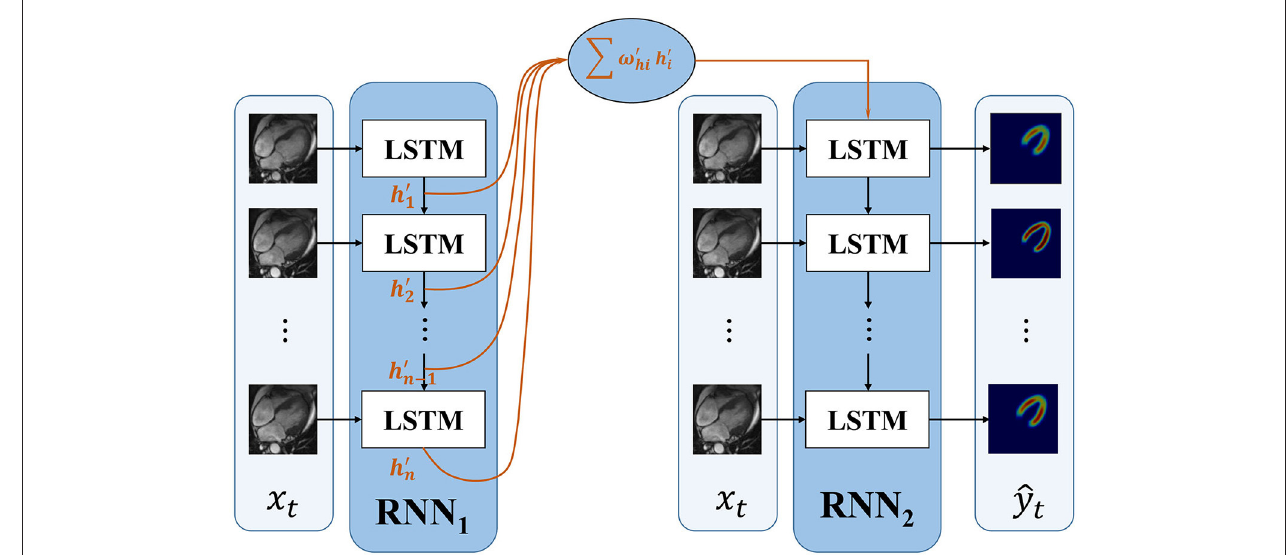
FIGURE 3 | The framework of the proposed dense